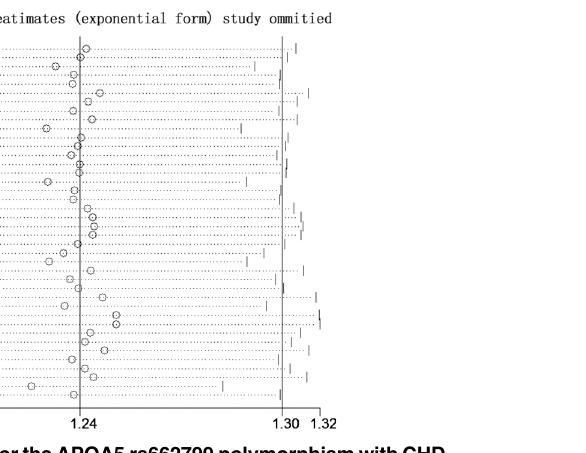
Fig 4. Sensitivity analysis for the APOA5 rs662799 polymorphism with